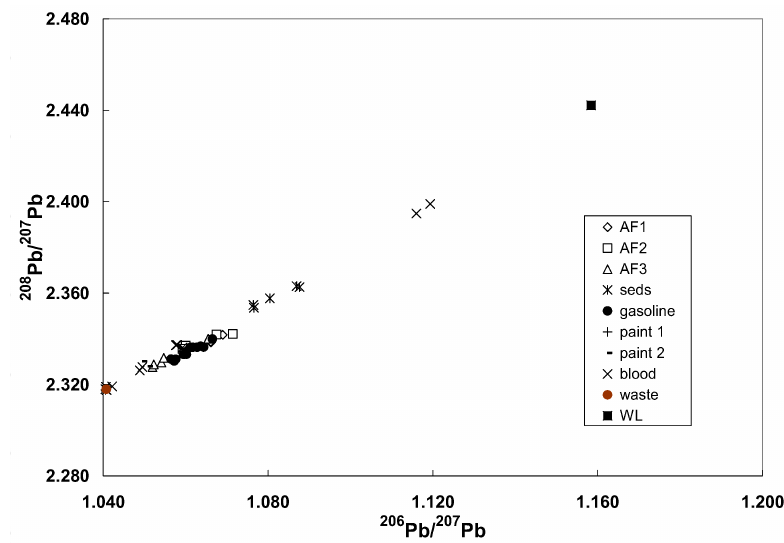
Figure 9. Plot of the isotopic data from Figure 7 on a 208 Pb/ 207 Pb versus 206 Pb/ 207 Pb